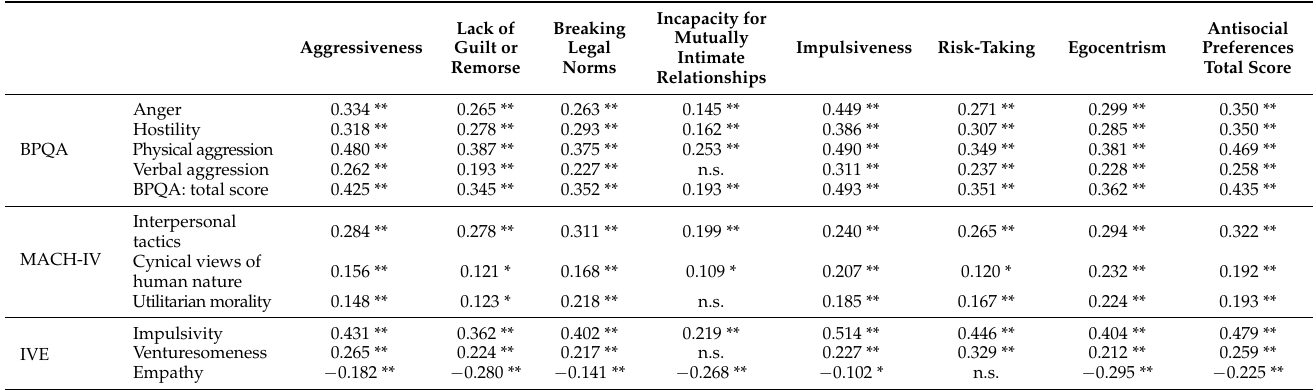
Table 7. Associations between the seven APS factors and external